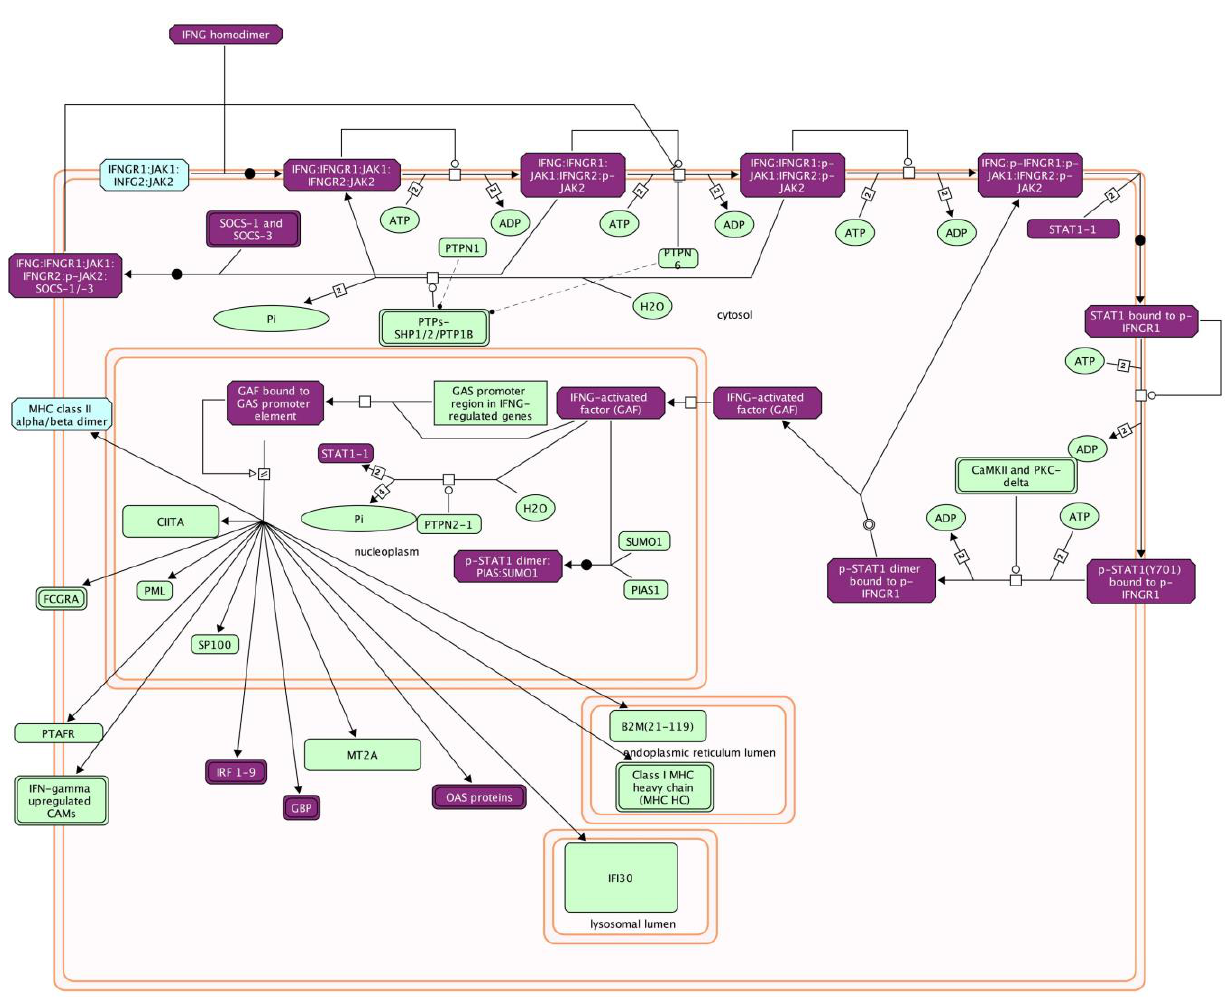
Figure 2. Reactome mapping of differentially-expressed genes. Abundance of differentially-expressed IFNγ pathway transcripts in Pirital arenavirus-infected